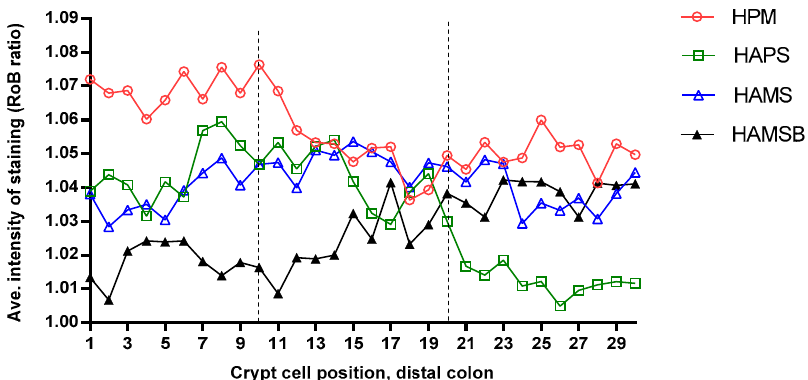
Figure 6. Average distribution of O 6 MeG DNA-adduct formation in the distal colon of rats receiving a high protein meat (HPM), the HPM diet plus 10% high-amylose maize starch (HAMS), the HPM plus 10% high-amylose potato starch (HAPS), or the HPM plus 10% butyrylated HAMS (HAMSB), for four weeks. The highest cell number on the X-axis represents the top of the crypt, with the delineations for the lower-, middle-, and the upper-crypt-thirds. Data are presented as red color over blue color ratio (RoB); a higher value represents a higher intensity of positive staining in the cell nucleus.